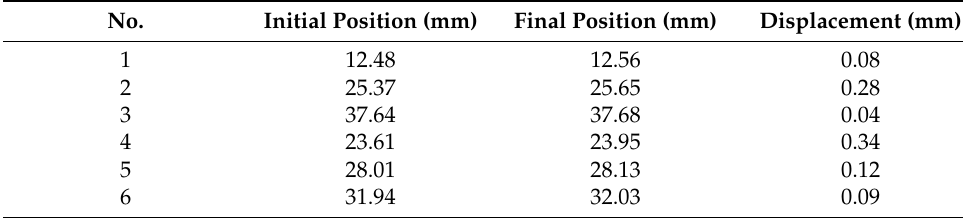
Figure 10. The platform for the loading experiment of the snake arms. Table 3. The displacement of the snake arms in the direction of load.